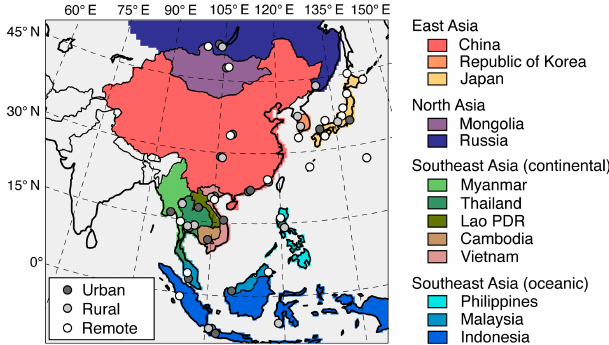
Figure 1. Map of the unified domain of MICS-Asia phase III. Circles with different colors indicate observation sites in remote (white), rural (light gray), and urban (dark gray) areas as classified by the EANET definitions. Map colors indicate the 13 countries participating in EANET in 2010 that were used for the analysis of deposition amount, which were classified into four regions in this